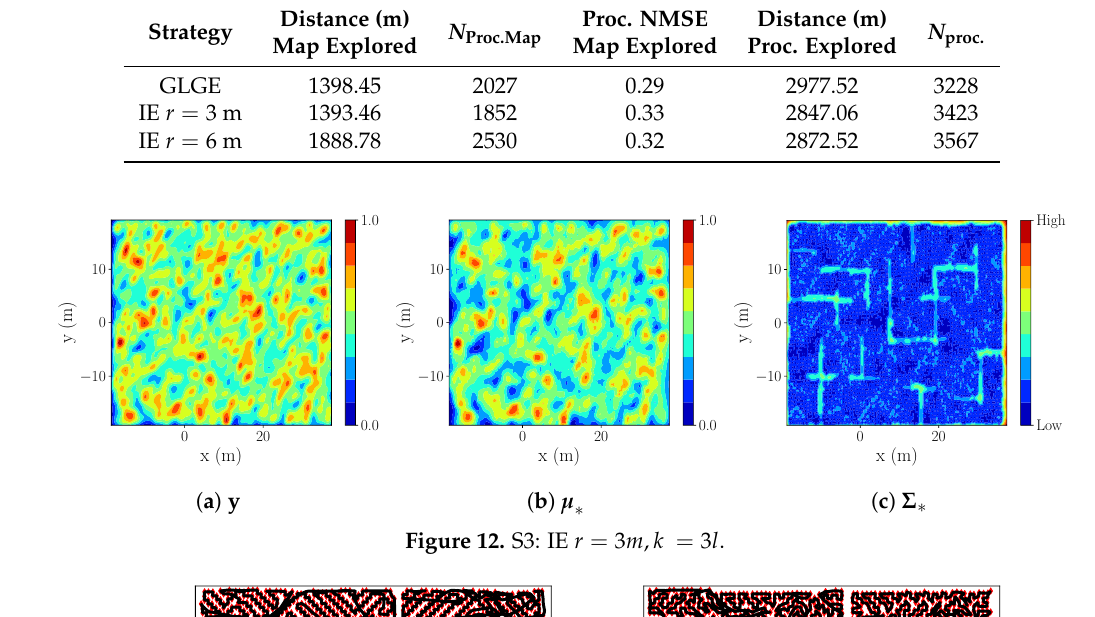
Figure 12. S3: IE r = 3 m , k = 3 l .